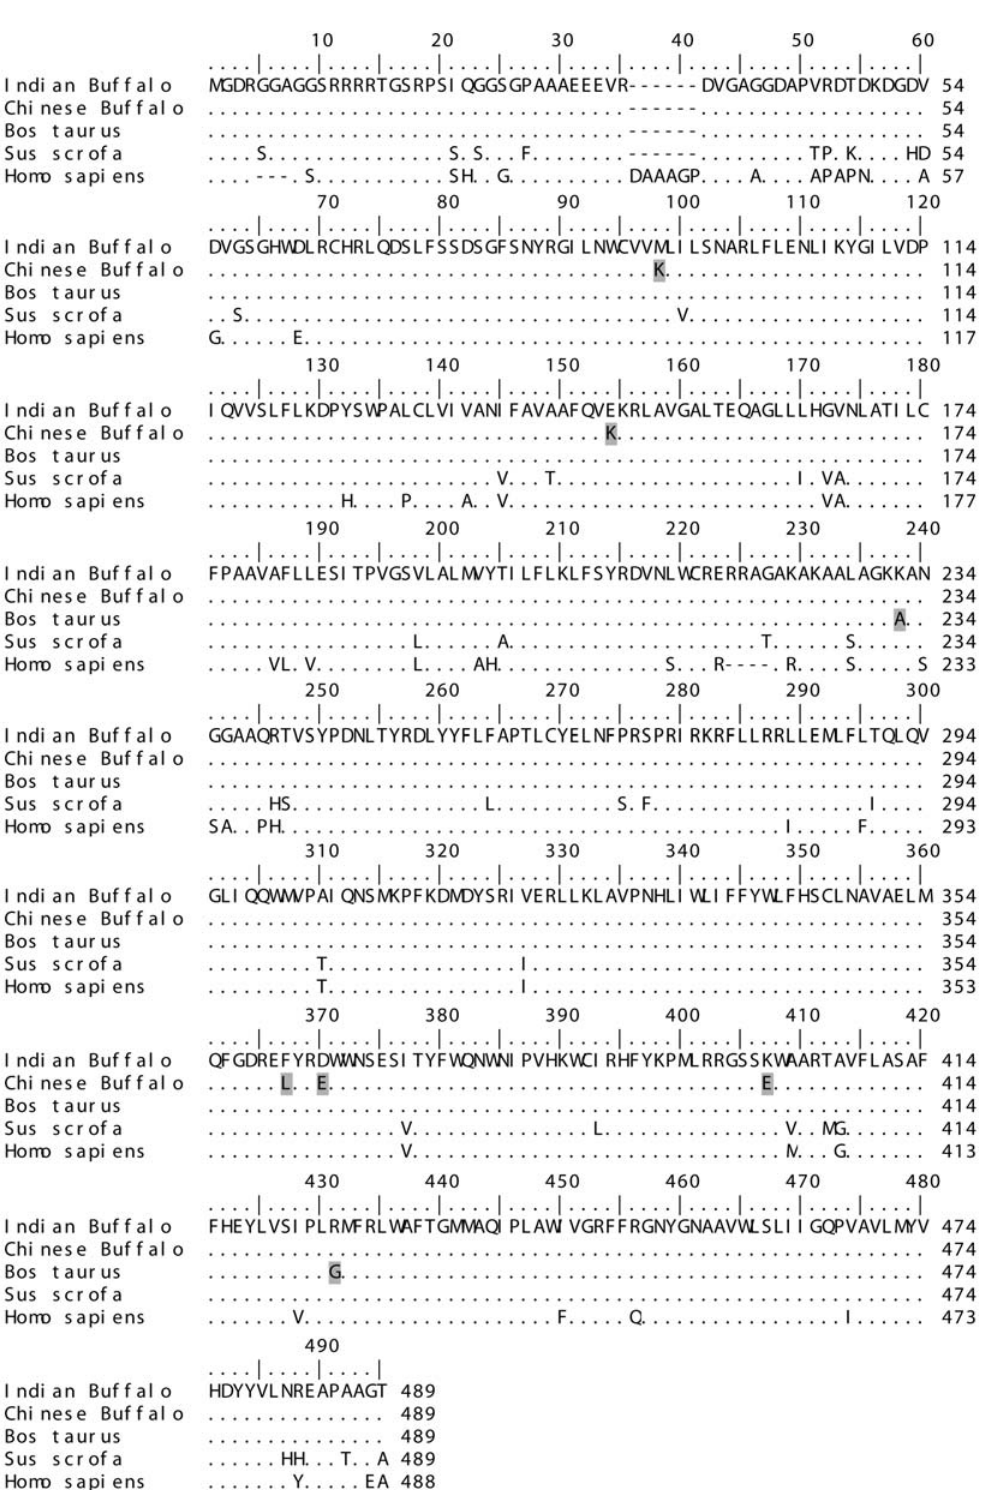
Figure 1 - Clustal-W alignment of the DGAT1 amino acid